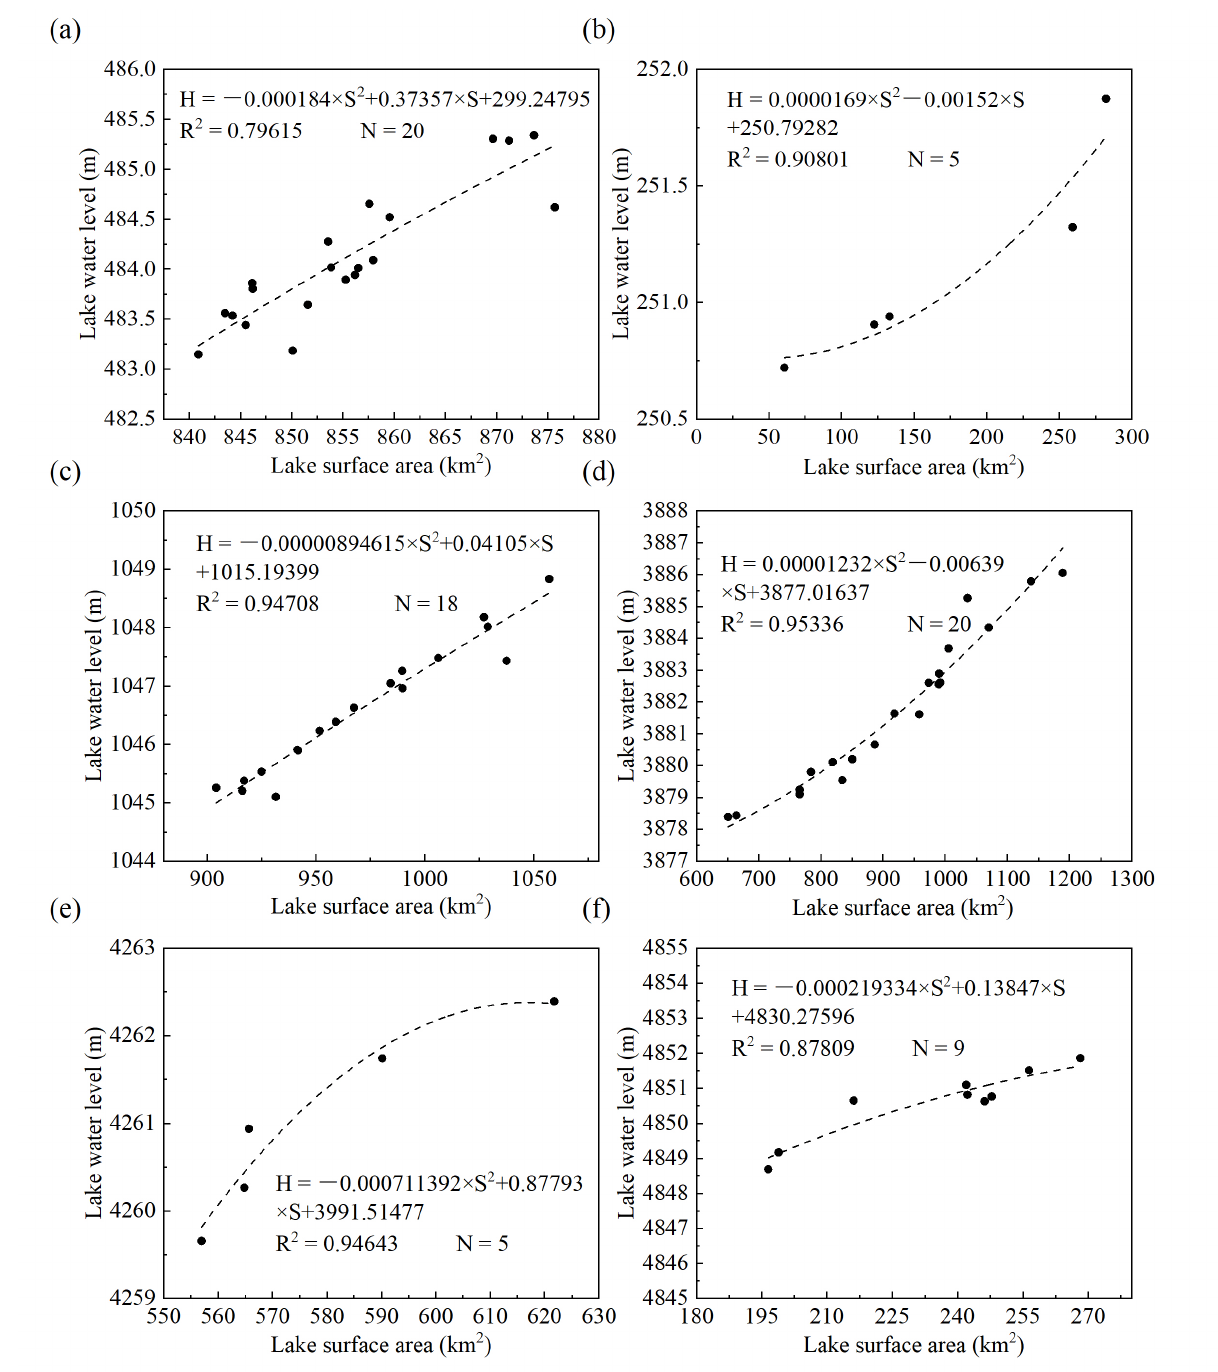
Figure 2. The quadratic models of lake area and lake water level ( a ) Ulungur Lake; ( b ) Manas Lake; ( c ) Bosten Lake; ( d ) Ayakkum Lake; ( e ) Aqqikkol Lake; ( f ) Aksayquin